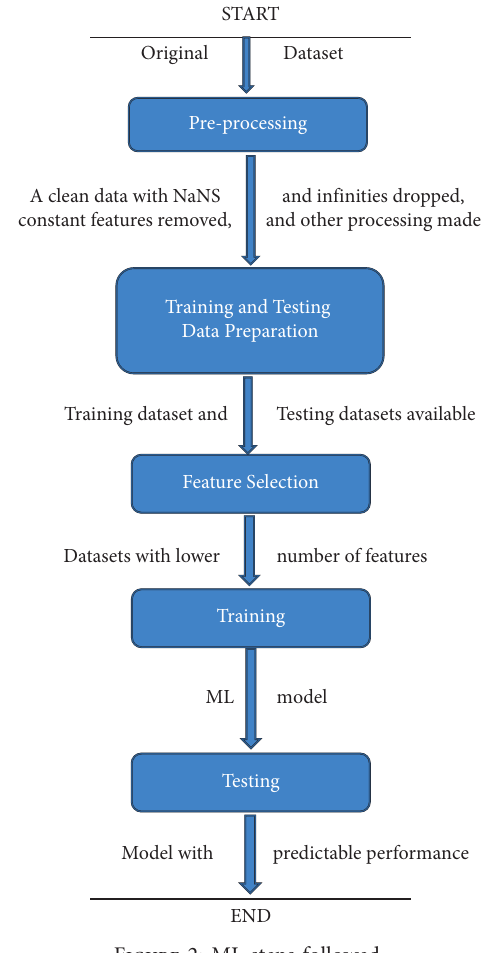
Figure 2: ML steps followed.